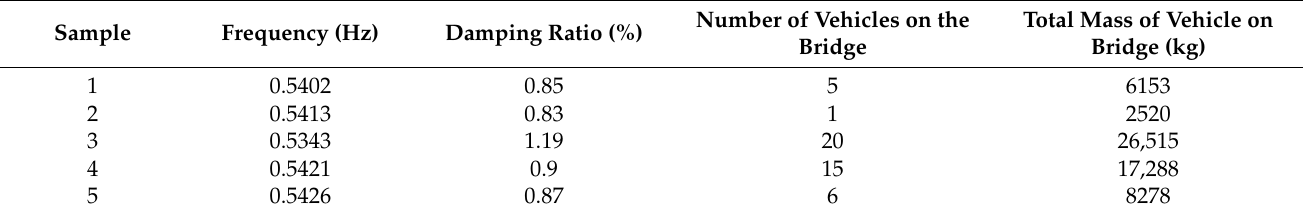
Figure 14. ( a ) Acceleration after band − pass filteringl ( b ) extracted decay response. Table 3. Modal parameter identification results.